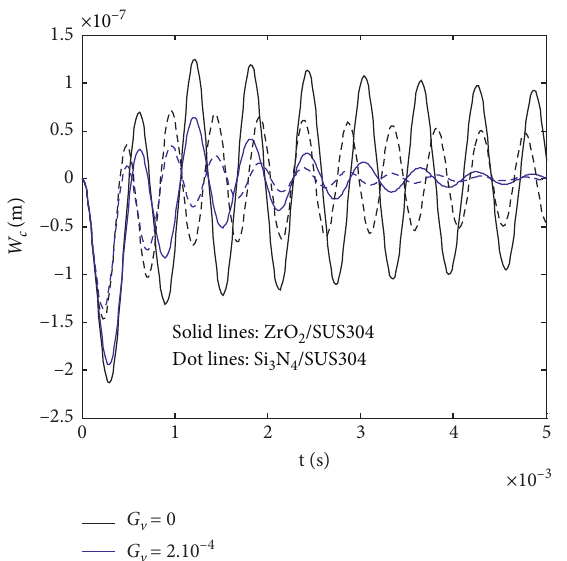
G v with two FG materials, n a on